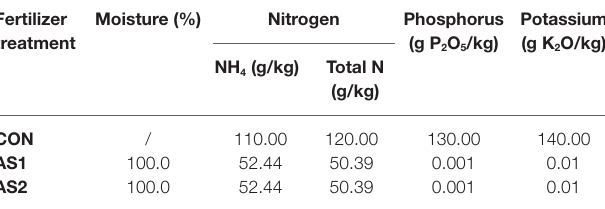
TABLE 1 | Physiochemical properties of tested fertilizers.